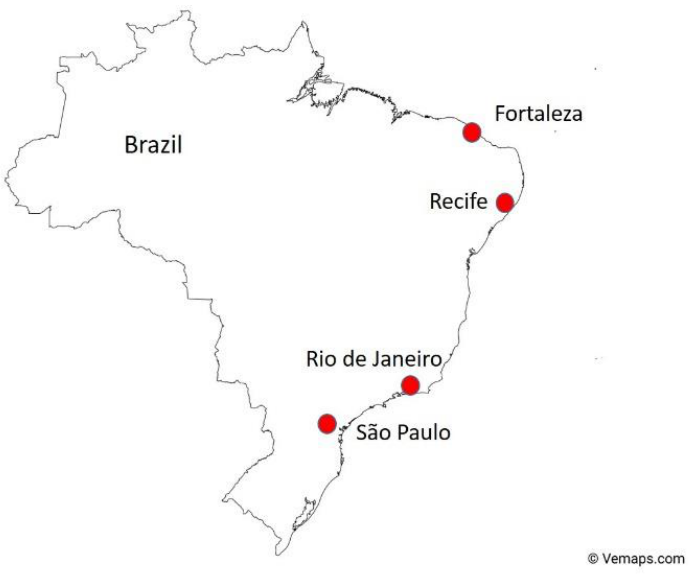
Figure 1. Location of the highest incidences of ZIKV and microcephaly cases in Brazil (Brazil Map by Vemaps.com, accessed on 20 January 2022).